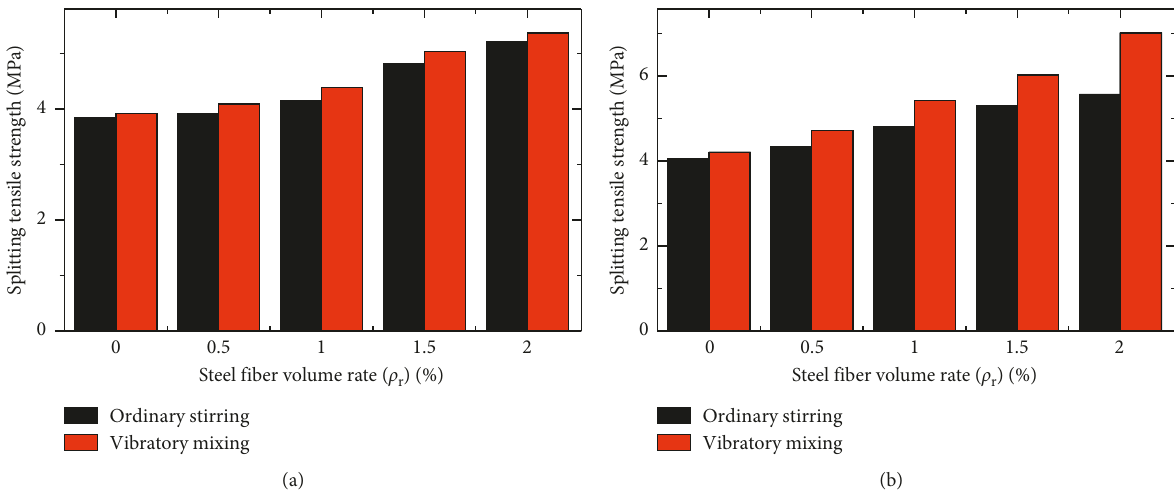
Figure 13: Effect of different mixing methods on the splitting tensile properties of steel fiber concrete. (a) CF50; (b)